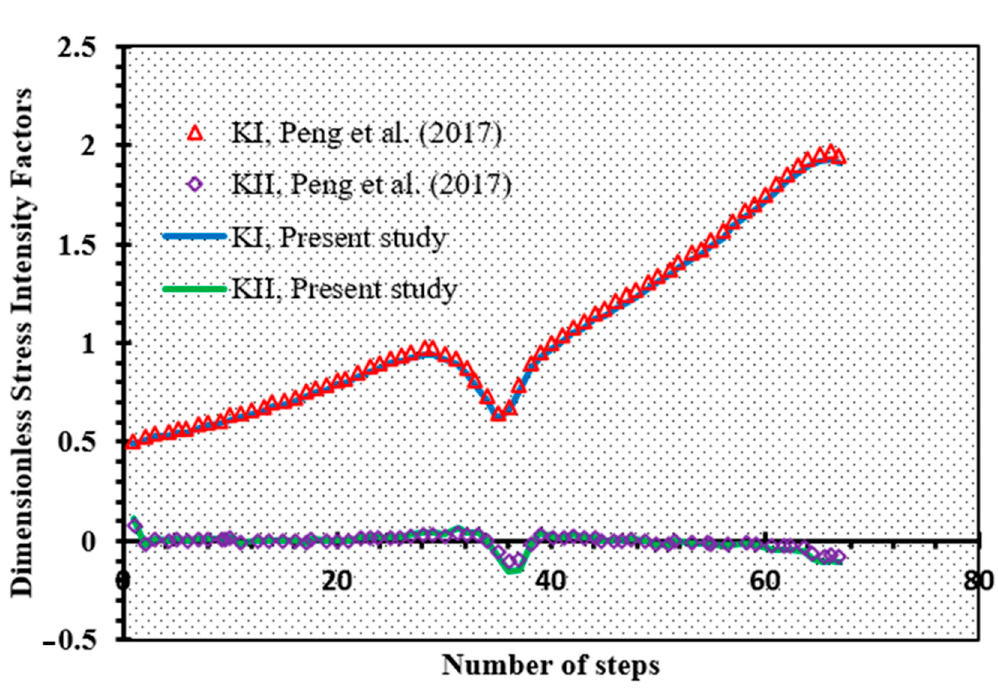
Figure 11. Non-dimensional stress intensity factors for case I of the PMMA specimen.